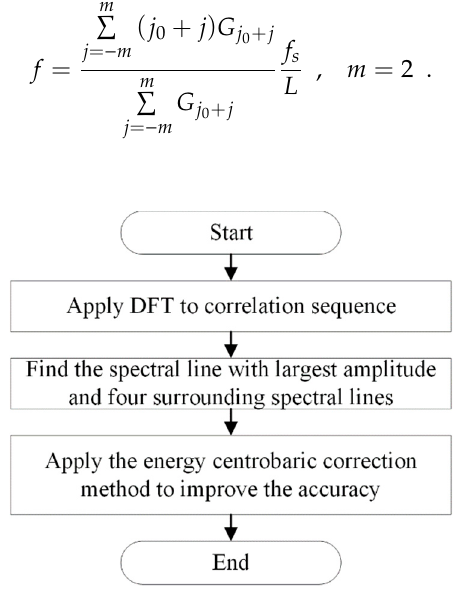
Figure 2. Flowchart of RPM measurement. DFT: discrete Fourier transform.